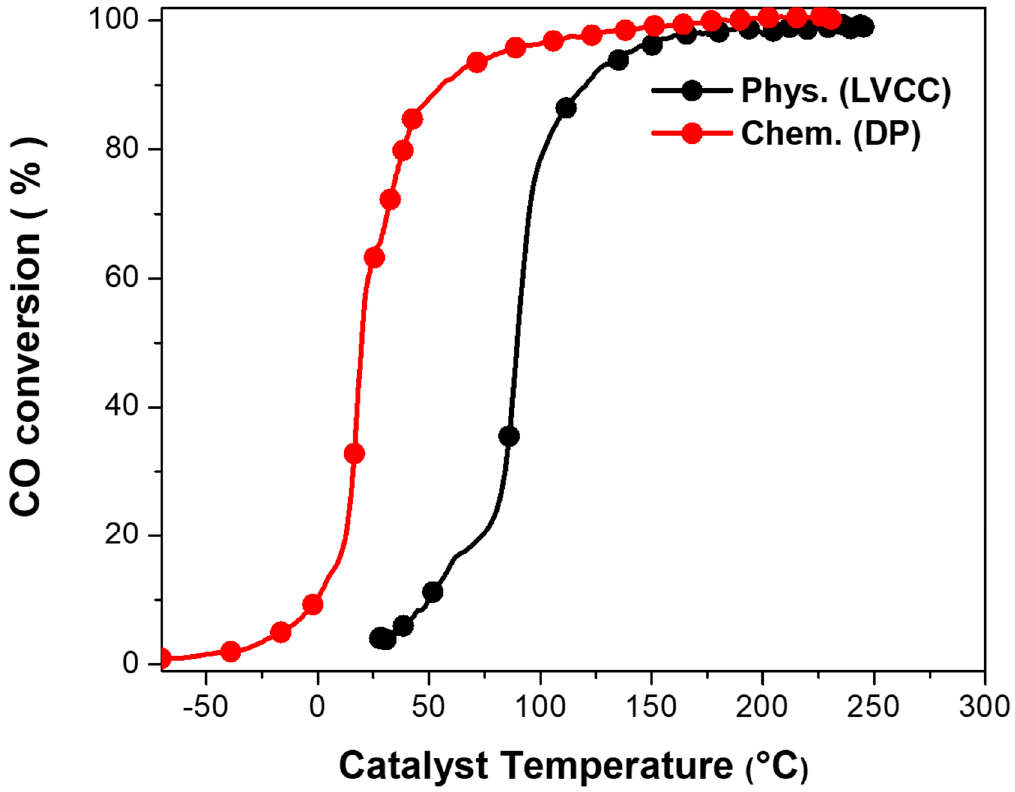
Figure 10. Comparison between Au/CeO 2 activities after heat treatment in CO/O 2 mixture prepared by LVCC and DP methods. Sample mass = 10 mg, flow rate = 100 cc/min.